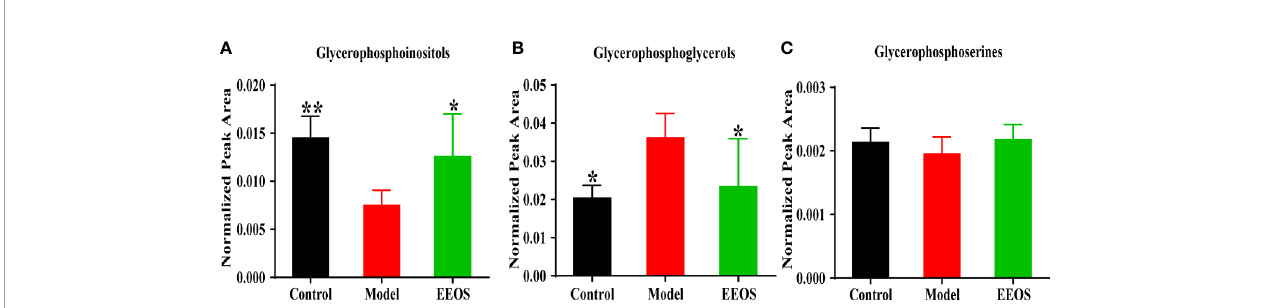
FIGURE 7 | Analysis of acidic glycerophospholipids in three groups. (A) The content of glycerophosphoinositols in each group. The model group was signi fi cantly decreased compared with the control group and EtOAc extract of OS (EEOS) group; (B) Analysis of glycerophosphoglycerols in three group; (C) Glycerophosphoserines no difference between the three groups. Data are expressed as mean ± SD. * P < 0.05, ** P < 0.01 vs. the model group.